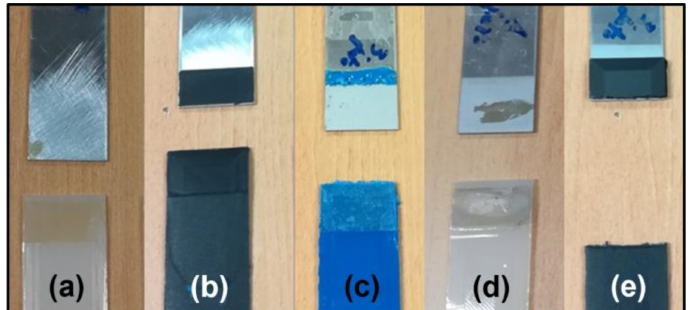
Figure 7. Photograph of each single-lap joint’s failure mode: ( a ) aluminium-PA abraded by SP, ( b ) aluminium-PA + CF abraded by SP, ( c ) aluminium-ABS abraded by GB, ( d ) aluminium-PA + CF abraded by GB, and ( e ) aluminium-PA + CF abraded by